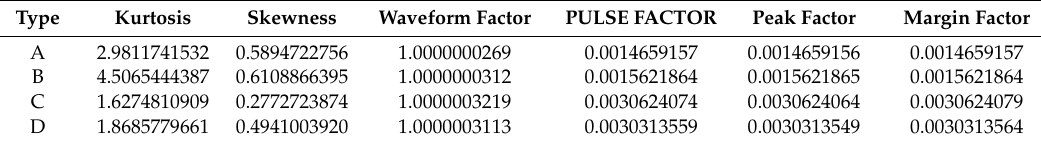
Table 2. Mean comparison of the dimensionless parameter from tactile signals.